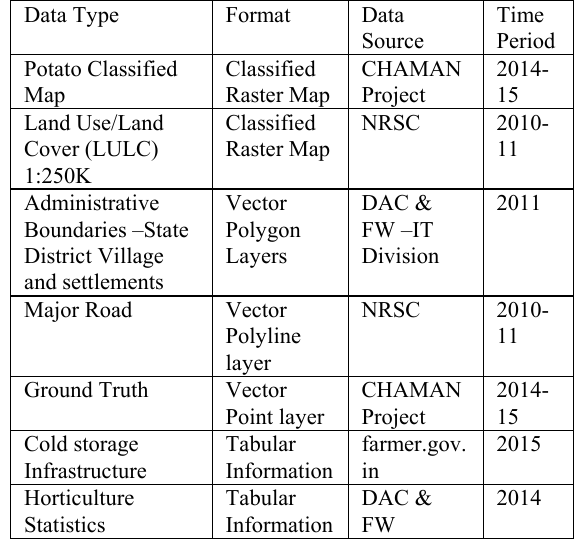
Figure 2. Pilot Study Area the state of Bihar